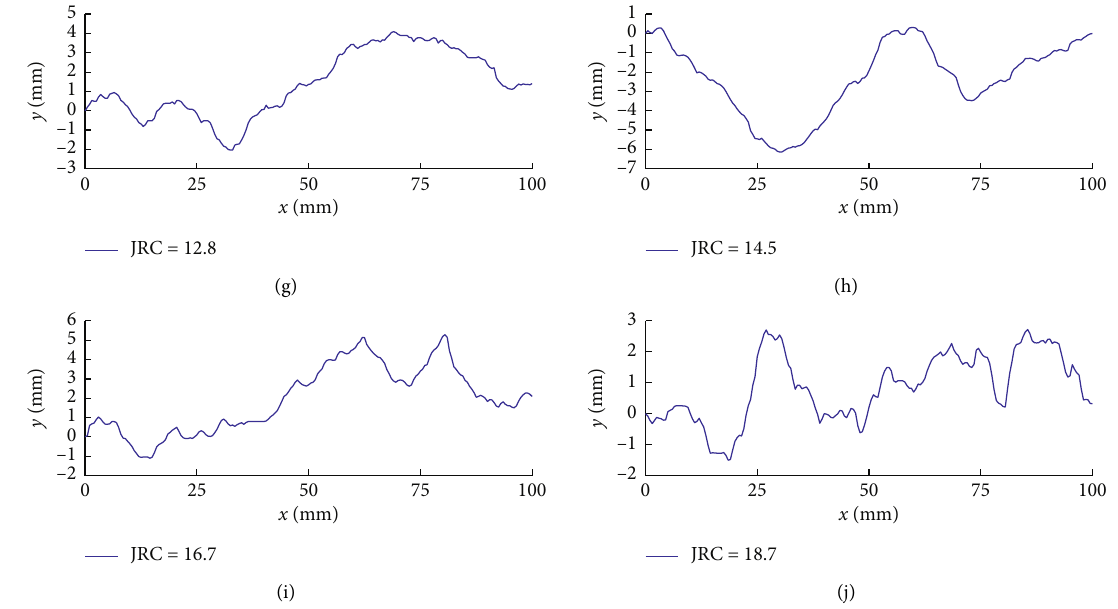
Figure 5: The modified 10 standard roughness profiles. (a) Profile 1. (b) Profile 2. (c) Profile 3. (d) Profile 4. (e) Profile 5. (f) Profile 6. (g) Profile 7. (h) Profile 8. (i) Profile 9. (j) Profile 10.